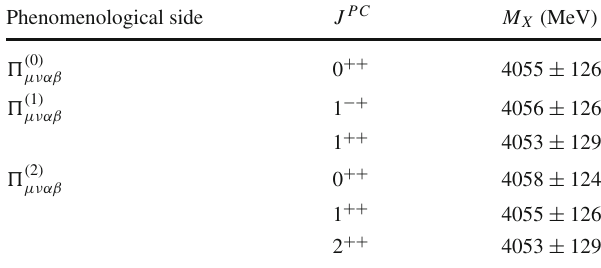
Table 1 Mass spectrum of X ( 3872 ) partners